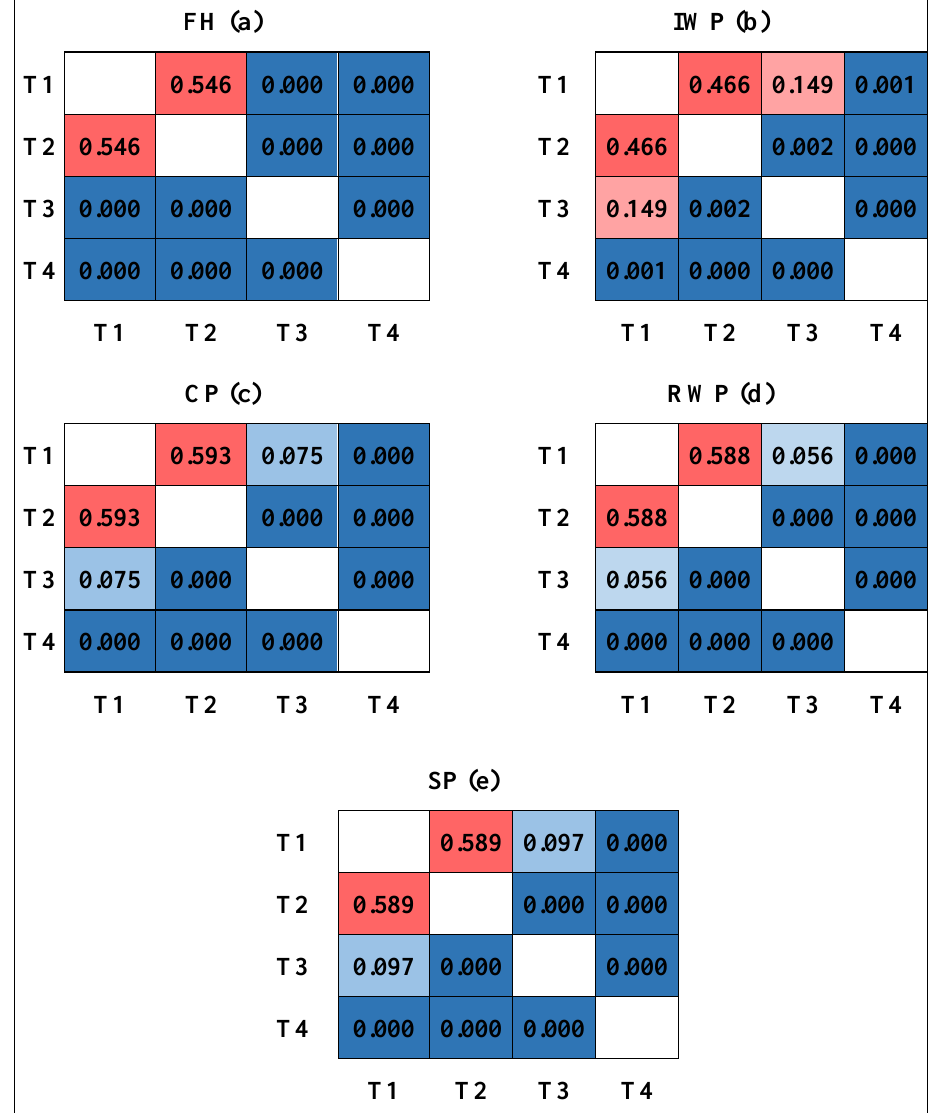
Figure 6. Tukey test results for NEB sub-regions by microphysical parameters of lightning-generating clouds ( a ) Freezing Level Height, ( b ) Ice Water Path, ( c ) Convective Precipitation, ( d ) Rain Water Path, ( e ) Surface Precipitation. Significant values ( p -value < 0.1) are represented with shades of blue, while non-significant values have shades of red.